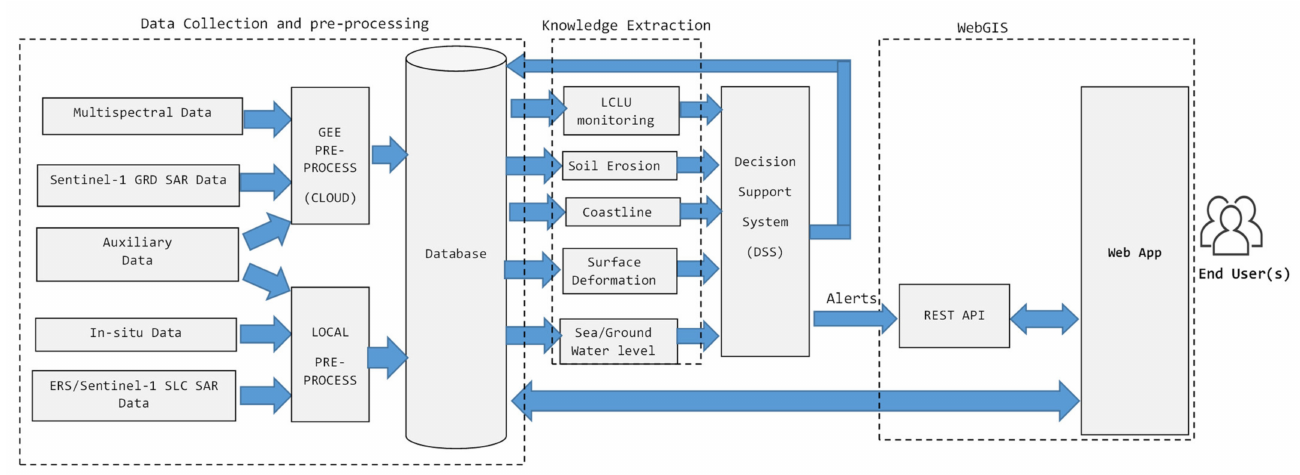
Figure 2. The proposed platform